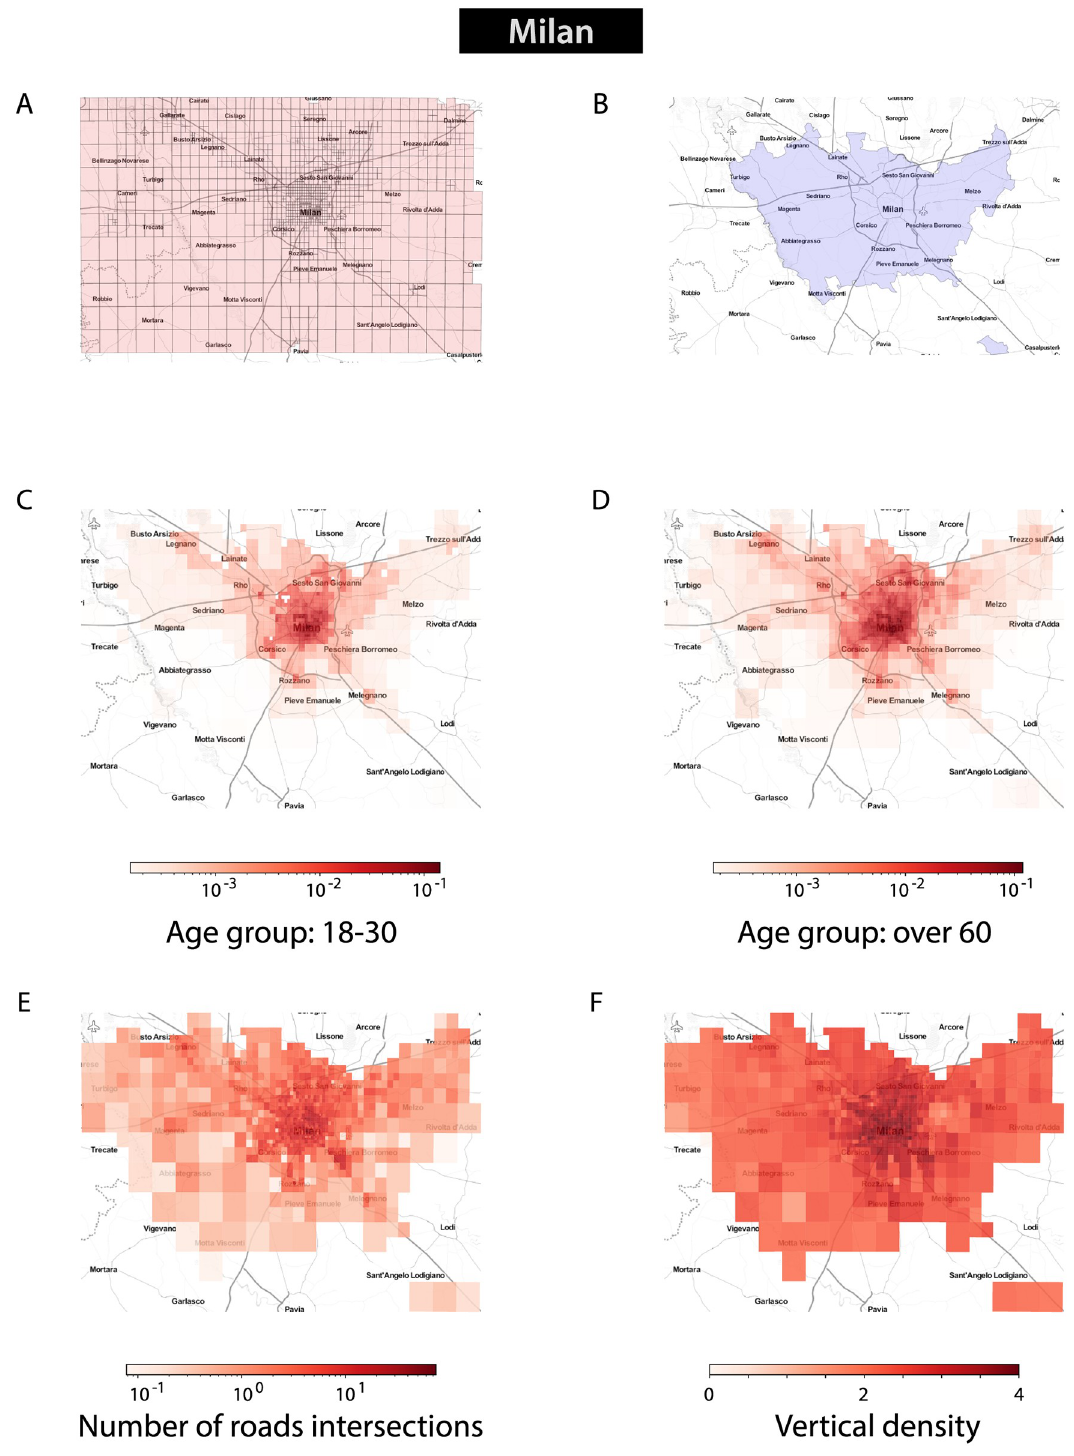
Fig 1. Presence of mobile phone users and density of urban features in Milan. We retrieve data on the number of mobile phone users in the city of Milan, together with their age group, as derived from Telecom Italia data between March and April 2015. (A) Mobile phone users are provided for cells in a discrete grid superimposed on the city. We depict here all the cells which are included in the dataset for the metropolitan city of Milan. (B) Our analysis focuses on urban environments in densely populated areas. We present here the geographical boundaries of the administrative unit of the metropolitan city of Milan, which we use to select those